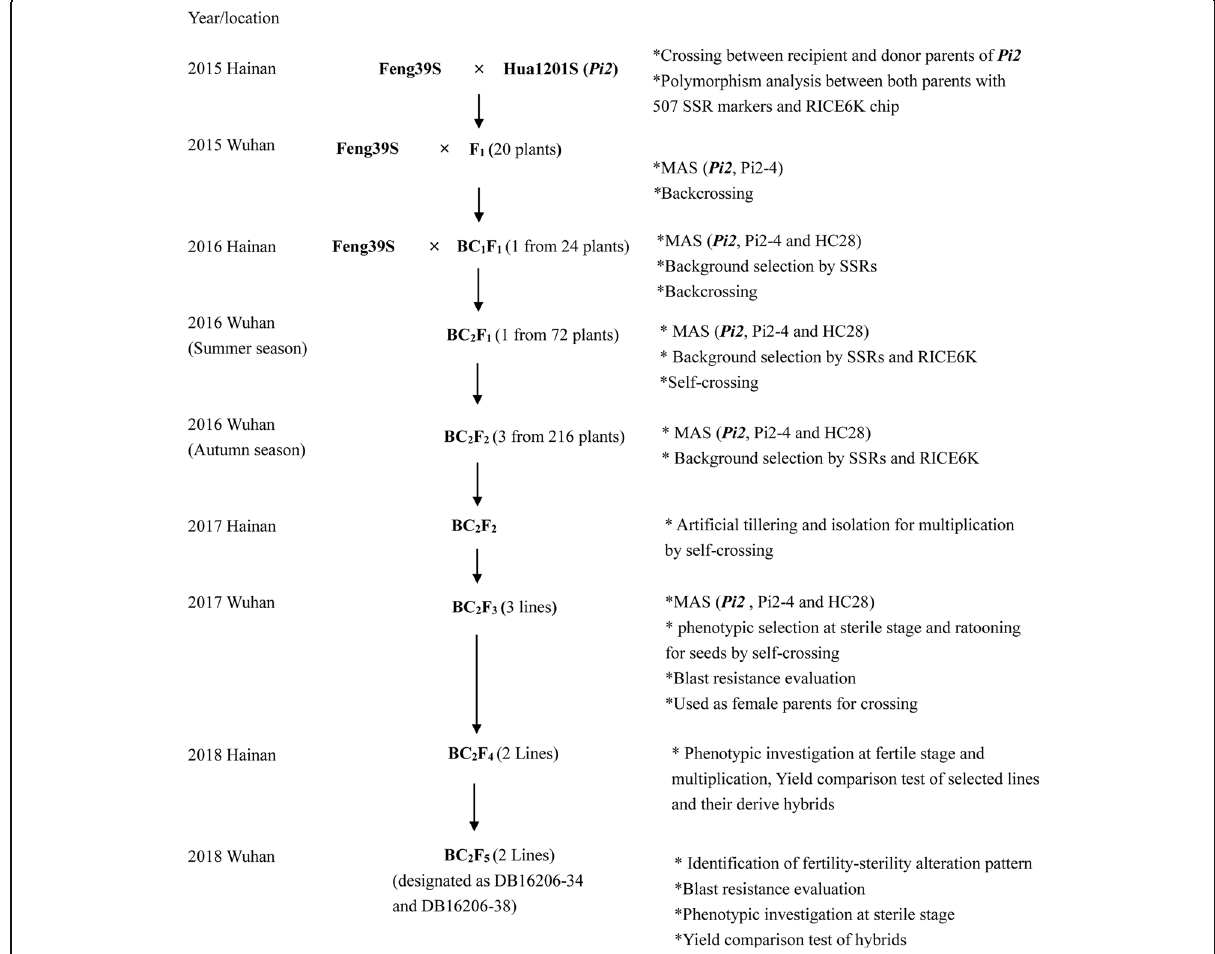
Fig. 1 The scheme for breeding new PTGMS lines stacking Pi2 gene by